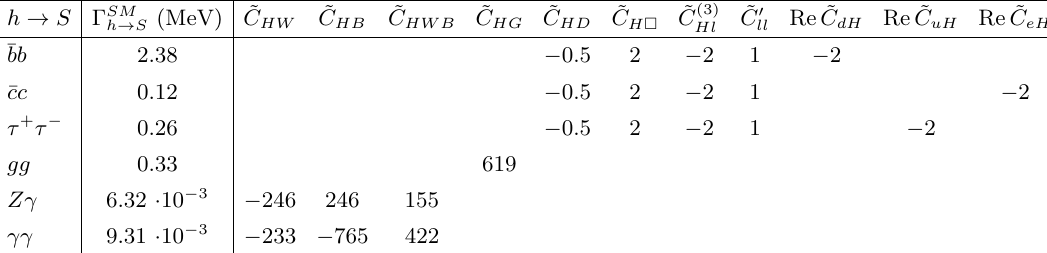
Table 8 . Partial SM Higgs decay width and coe(cid:14)cients a ( S )